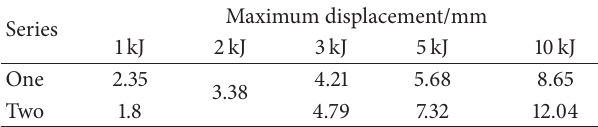
Table 7: Maximum displacement of slab without cushion